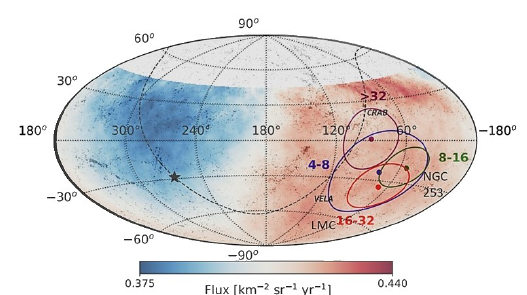
Figure 2: The galactic UHECR map overlaid on the re- cent 39 EeV anisotropy map, shows the earliest (2011) UHECR events and the associated 20 EeV smeared mul- tiplet, up and down respect to the Cen A position. We in-